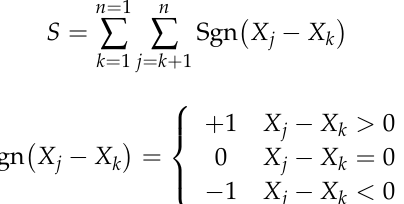
Figure 3. Original and interpolated hypothesized time series (adapted from Figure 4 on page 281 in the paper by J. Reiche et al [11]).